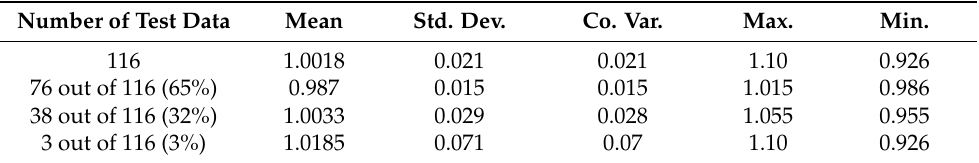
Table 4. Mean, standard deviation (Std. dev.), coefficient of variation (Co. Var.), maximum (Max.) and minimum (Min).